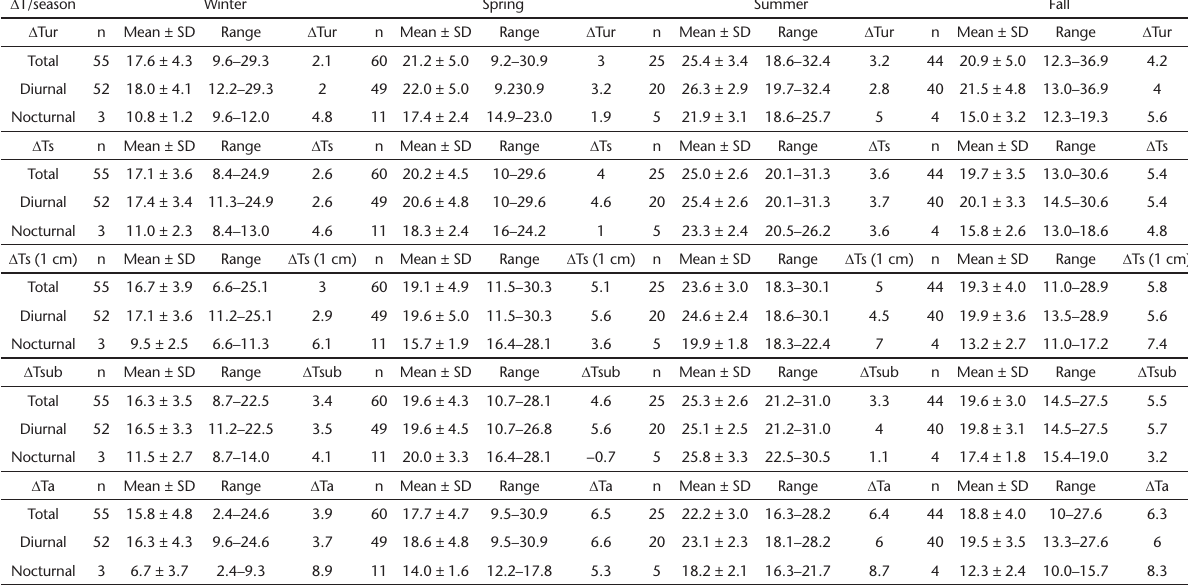
Table 3. Difference between the body temperatures of Amphisbaena munoai and the thermal environment ( ∆ T values) for individuals found in São Jerônimo between March 2011 and October 2012 (n = 185). Tur, temperature under a rock; Ts, substrate temperature; Ts (1 cm), substrate temperature 1 cm above the ground; Tsub, substrate temperature 5 cm below the ground; Ta, air temperature.